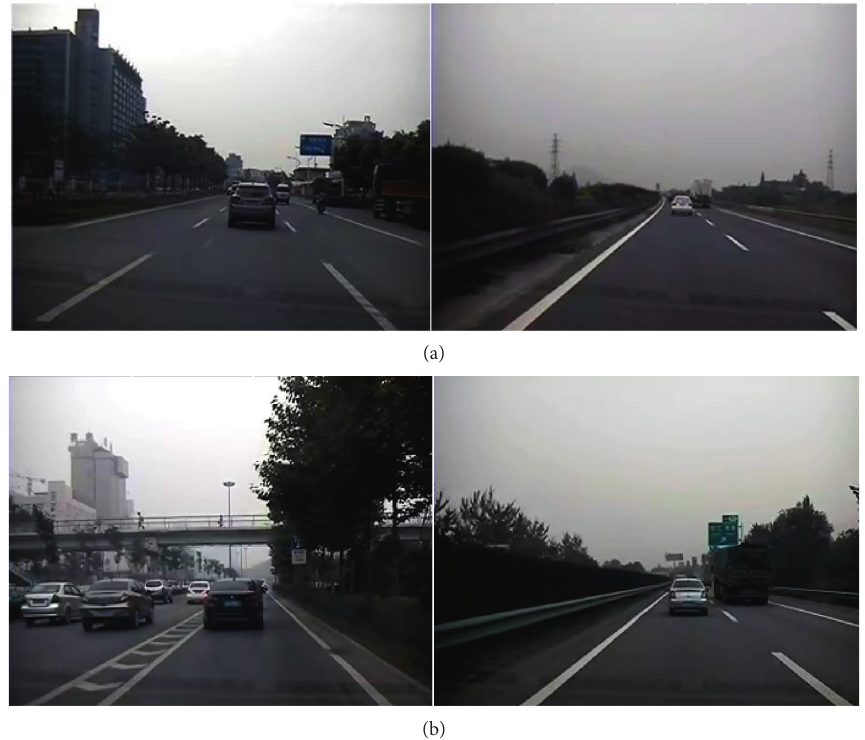
Figure 3: Driving scenarios in (a) Huzhou city and (b) Xi’an city.